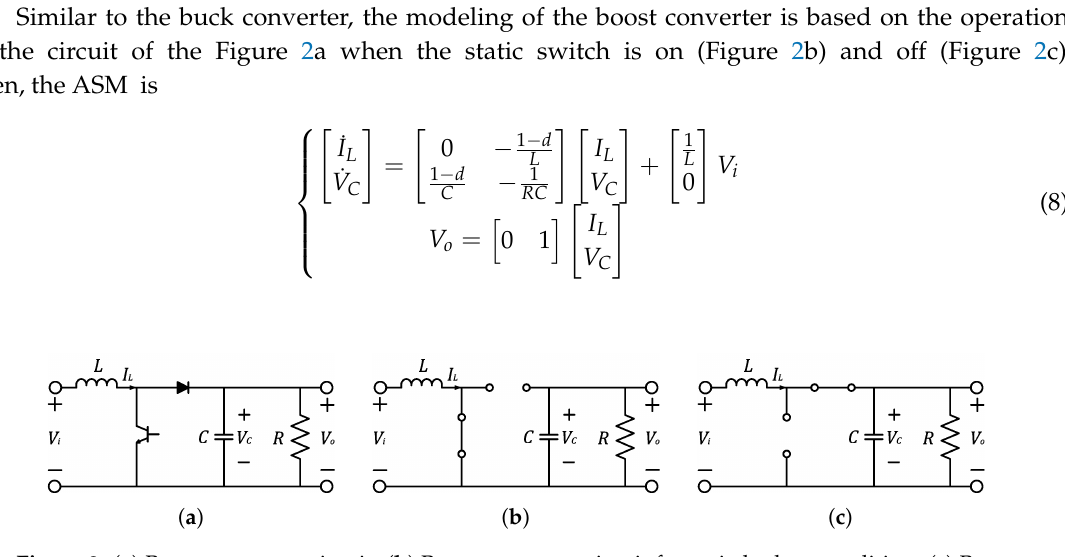
Figure 2. ( a ) Boost converter circuit. ( b ) Boost converter circuit for switched on condition. ( c ) Boost converter circuit for switched off